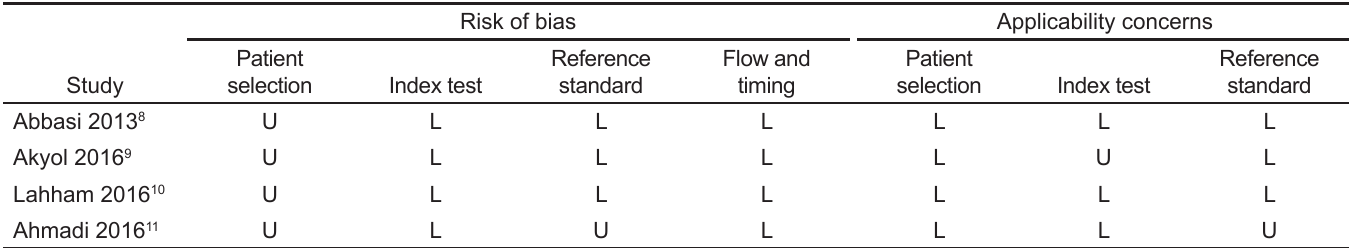
Table 2. QUADAS-2